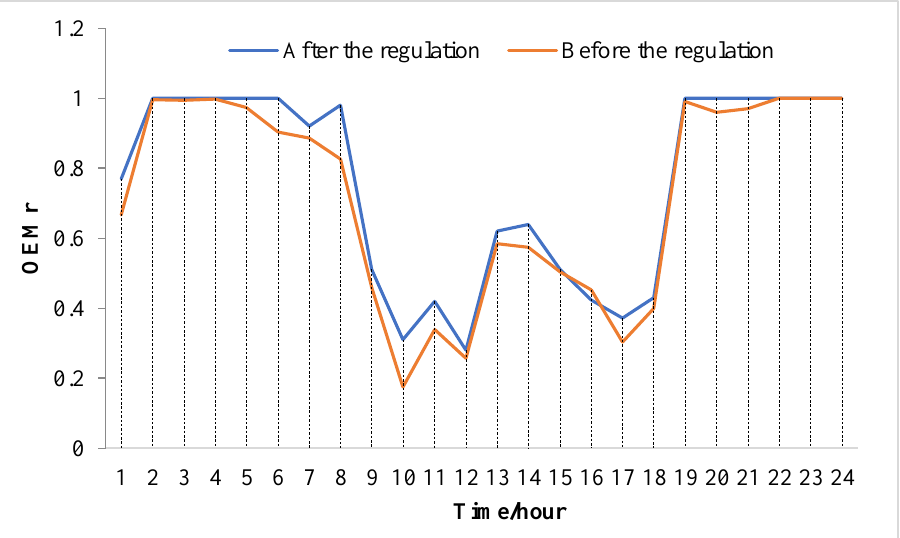
Figure 7. Comparison of OEM r before and after VES.